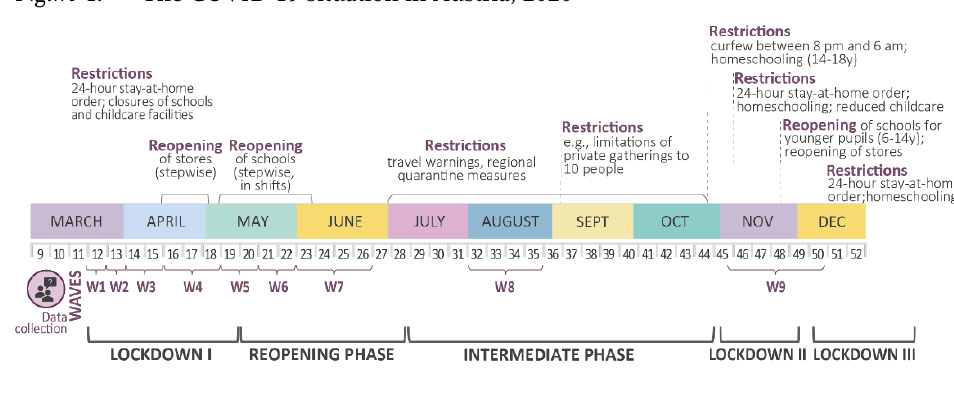
Figure 1 : The COVID-19 situation in Austria,